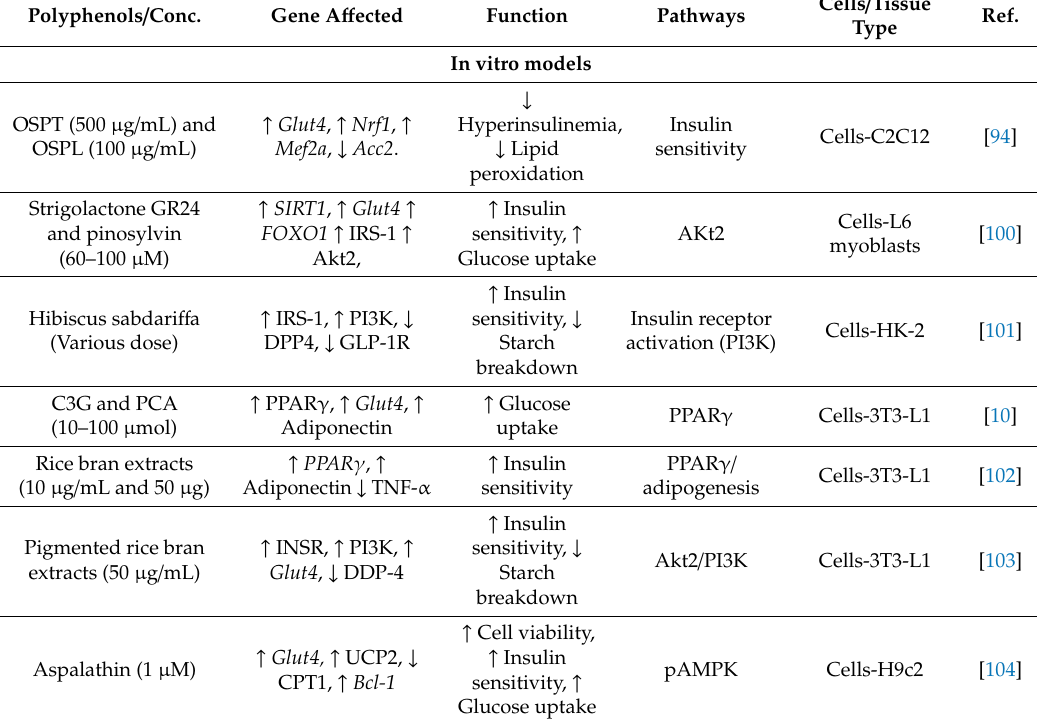
Table 3. Polyphenols and gene modulations on insulin signalling